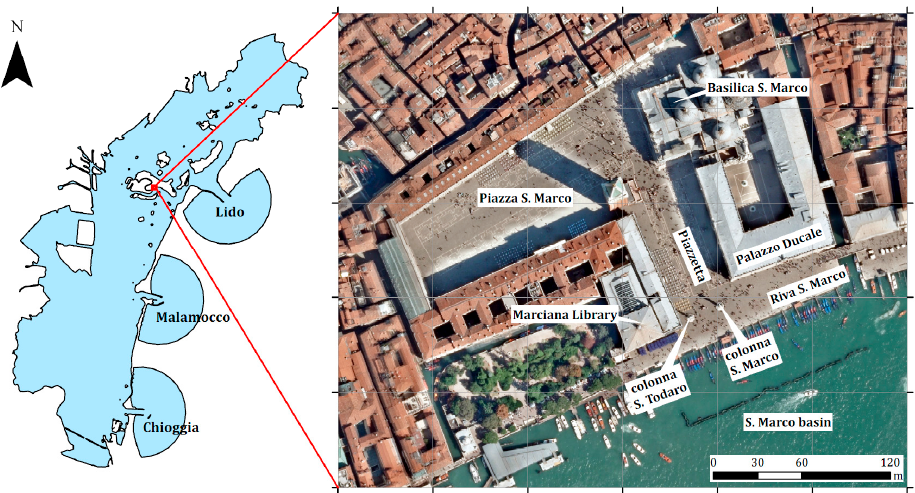
Figure 1. Location and orthophoto of the study site: Piazza S. Marco, Venice, Italy.